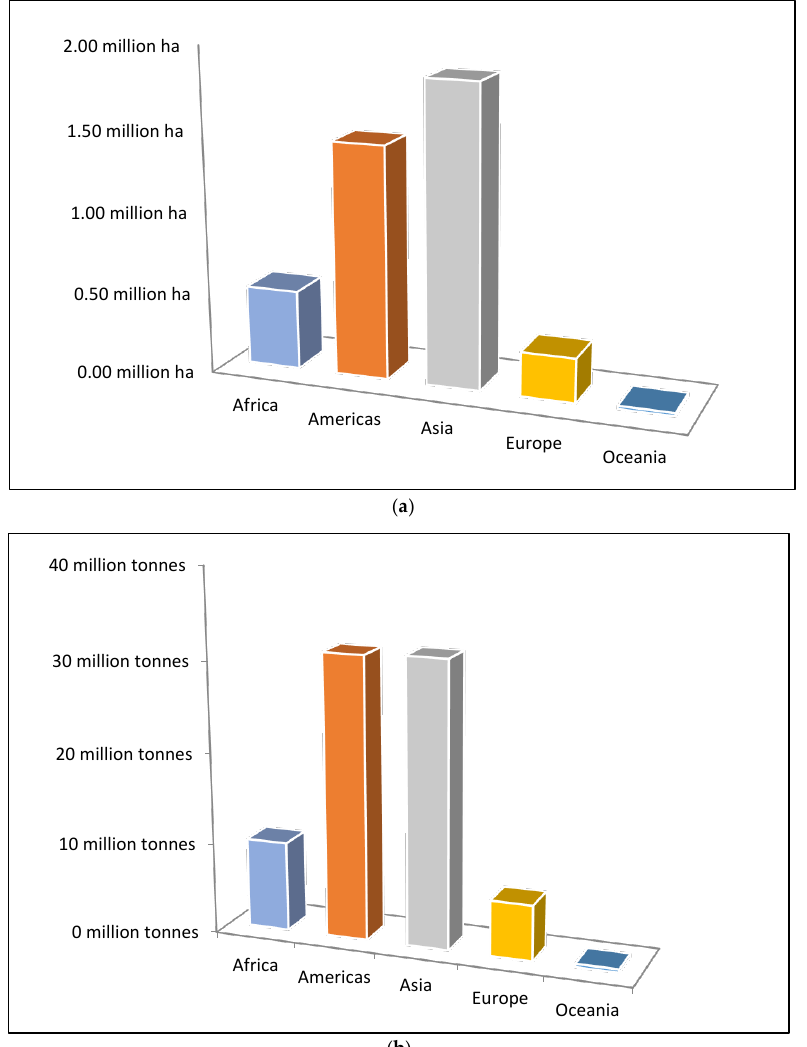
Figure 1. Harvested area ( a ) and production ( b ) of oranges in 2021 [8] .